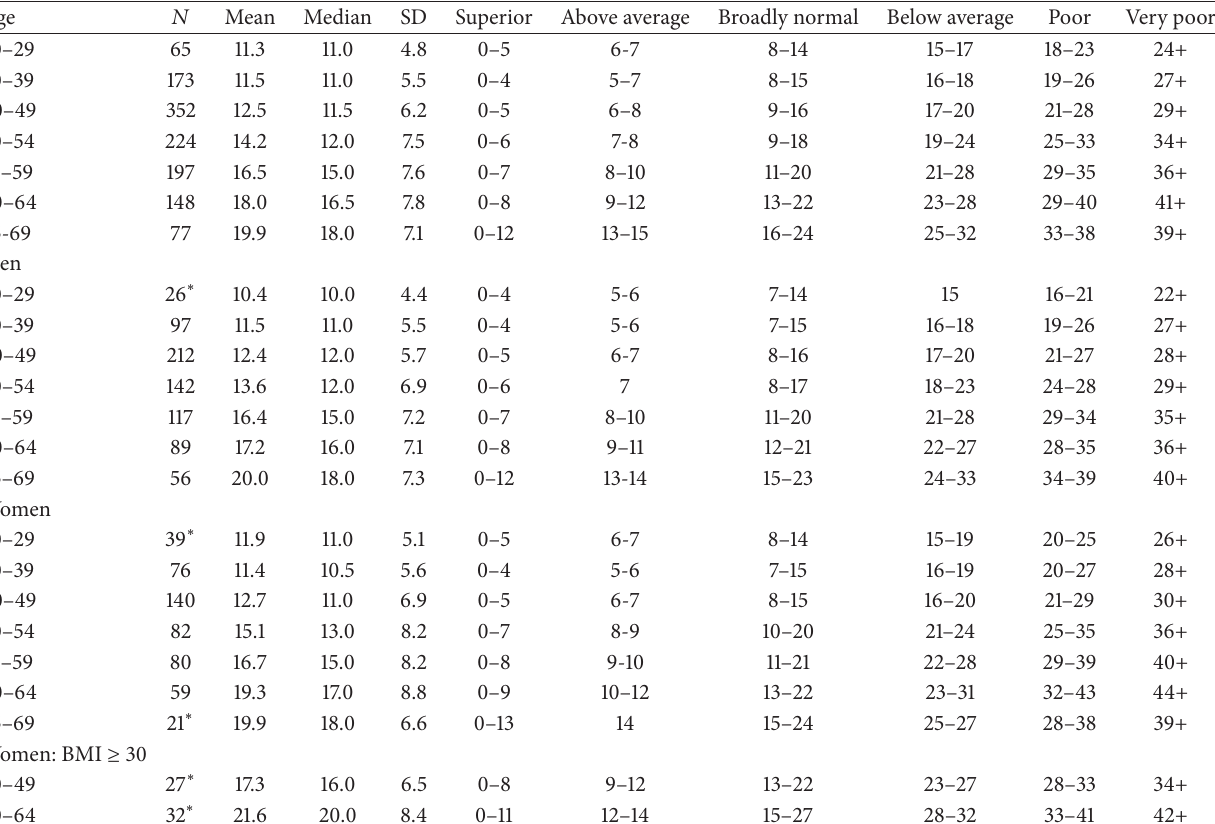
Table 1: Normative reference values for the BESS stratified by